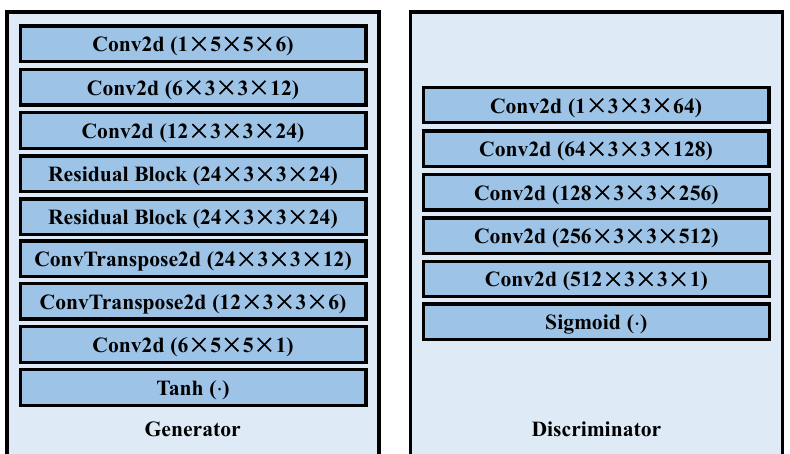
Figure 5. Network structures of the generator and discriminator of the CycleGAN in this study.